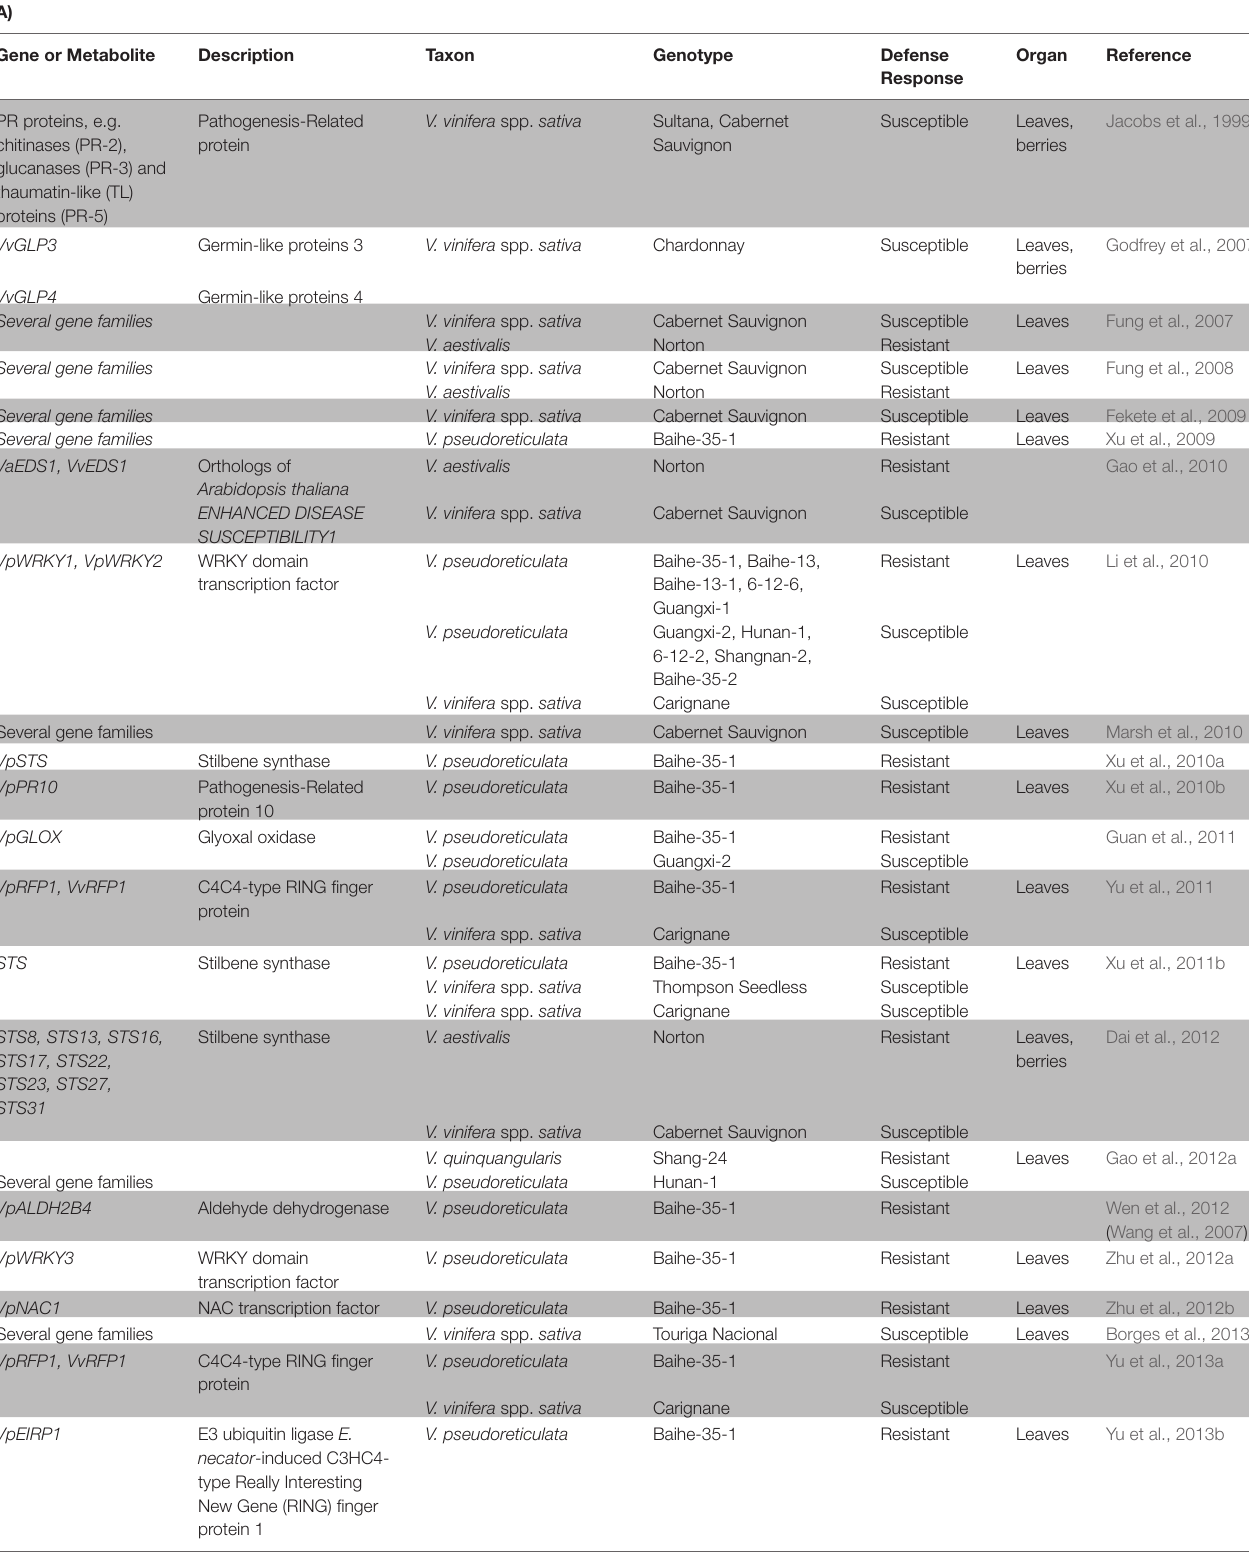
TABLE 2 | Transcriptomics, proteomics and metabolomics of grapevine-ascomycete interaction: E. necator (panel A) and E. ampelina (panel